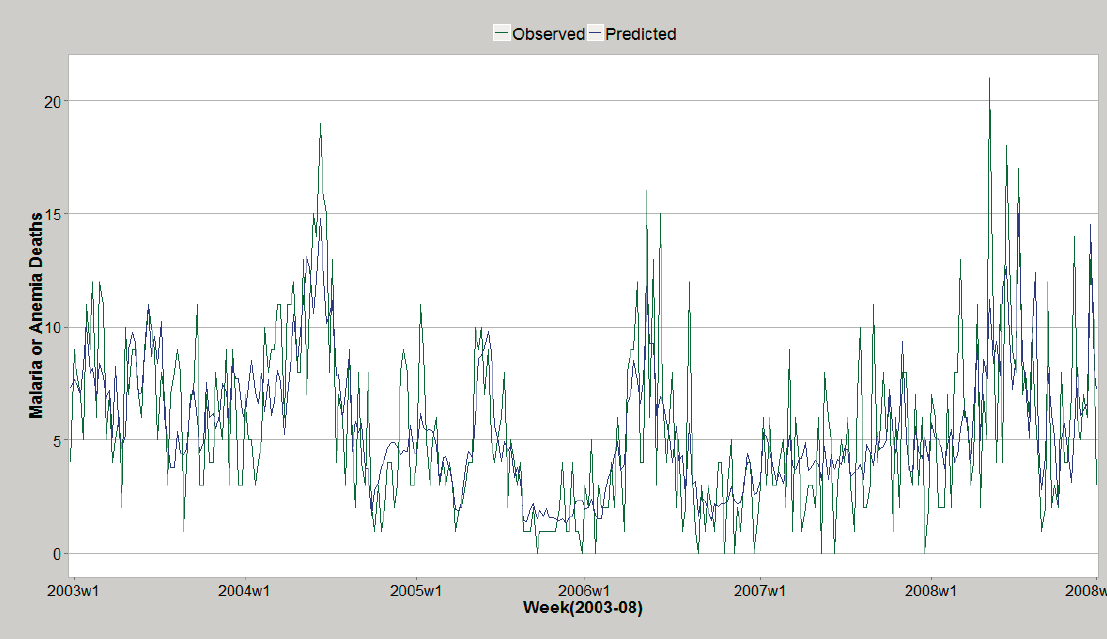
Figure 5. Malaria/Anemia observed deaths and model prediction 2003–2008 Asembo and